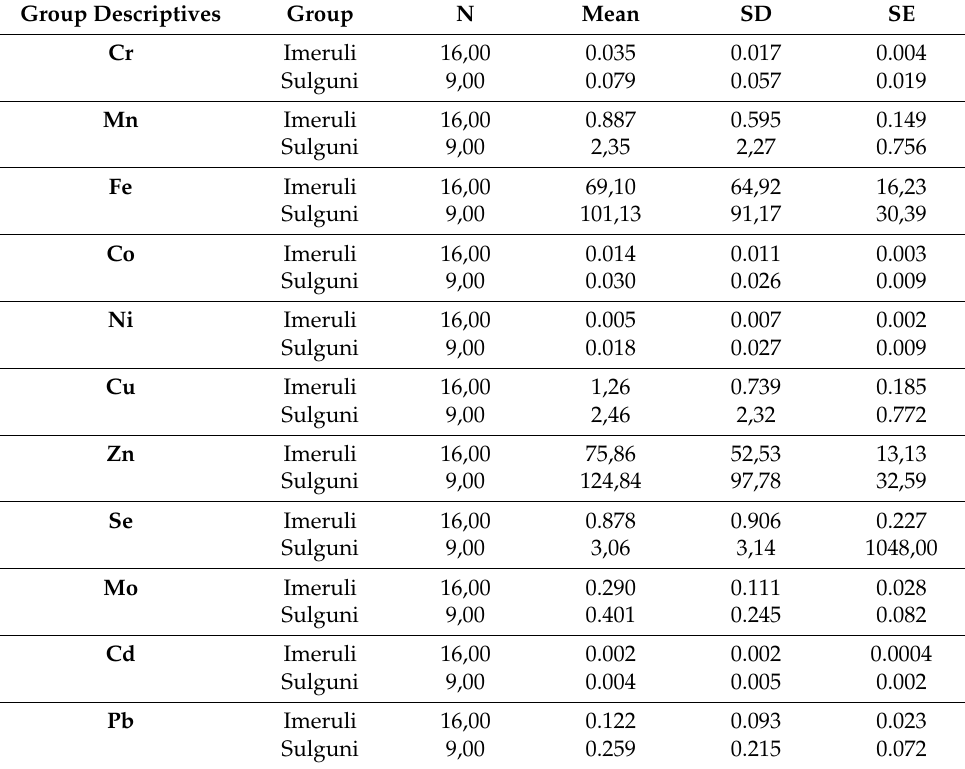
Table A1. Descriptive statistic of the trace elements in Sulguni and Imeruli